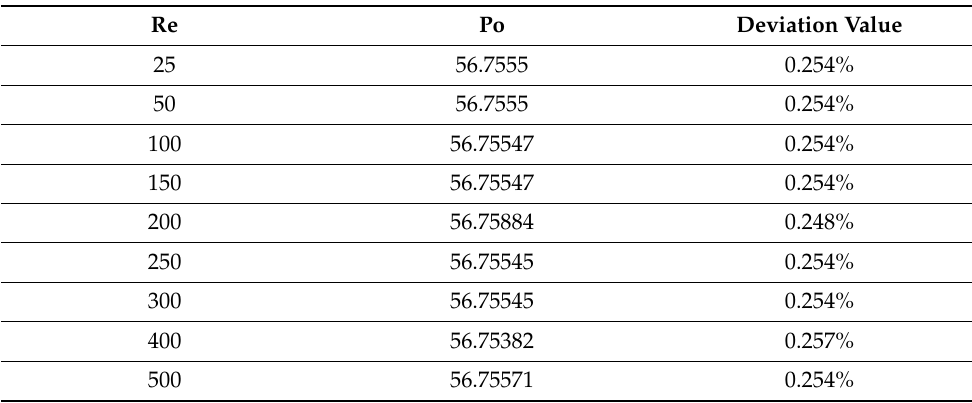
Table 4. Results of model